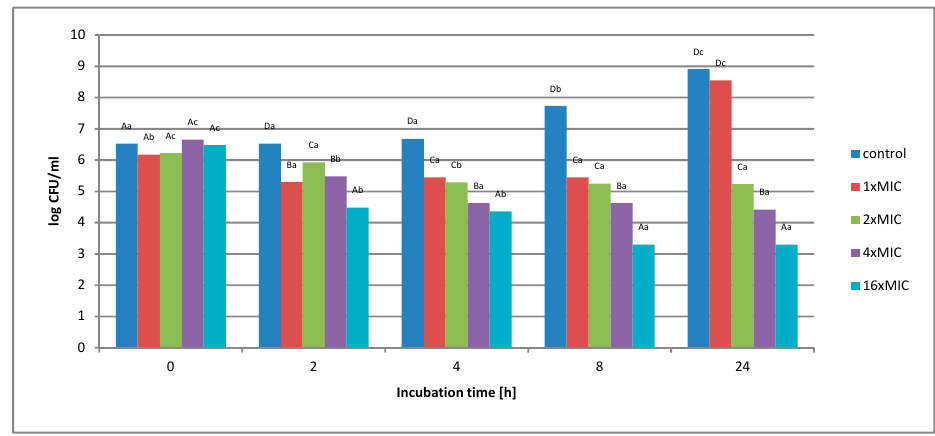
Figure 7. The effect of the aqueous extract at the concentration of 1 × MIC, 2 × MIC, 4 × MIC, and 16 × MIC on the survival of Salmonella Enteritidis in a matrix containing 12% meat extract during 24 h of incubation. A, B, C, D—the effect of matrix type on the change in the number of bacteria at the same time of storage; a, b, c, d—the effect of incubation time on changing the number of bacteria. The highest concentration of 16 × MIC aqueous extract (256 mg/mL) significantly reduced the number of S. Enteritidis cells after just 2 h of incubation. After 24 h of incubation, the number of bacterial cells decreased from 3.0 × 10 6 CFU/mL to 2 × 10 3 CFU/mL, i.e., by 3.1 log.